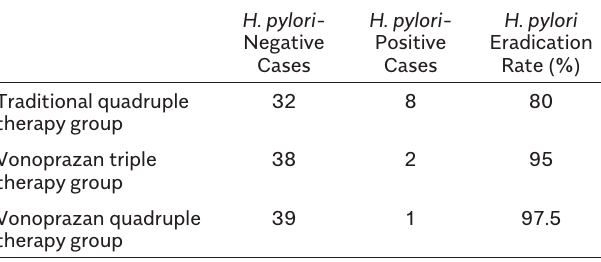
Table 2. Comparison of H. pylori Eradication Rate of the 3 Groups